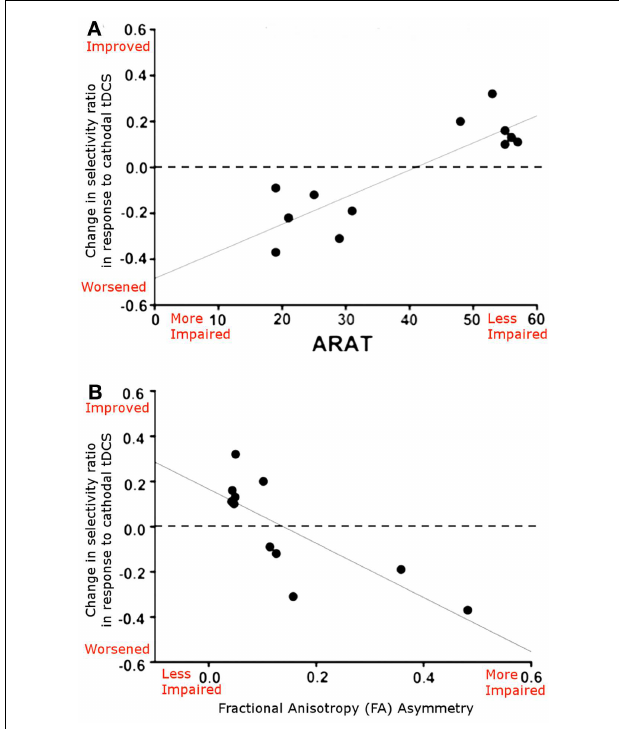
FIGURE 2 | (A) Relationship between the neurophysiological response to cathodal tDCS applied to the contralesional M1 (reported as selectivity ratio, where higher numbers reflect better responses) and ARAT score, a measure of functional impairment, where higher numbers reflect better functioning. Patients who are better recovered show a beneficial functional response to cathodal tDCS applied to M1 Cont , whereas those who are more poorly recovered show a neurophysiological worsening. (B) Scatterplot showing the relationship between the neurophysiological response to cathodal tDCS and structural integrity of the corticospinal tracts (reported as FA asymmetry, where higher values represent greater ipsilesional tract disruption). A clear relationship is demonstrated, whereby cathodal tDCS applied M1 Cont leads to a neurophysiological improvement in patients with good ipsilesional corticospinal tract integrity. Adapted from Figure 5, Bradnam et al.